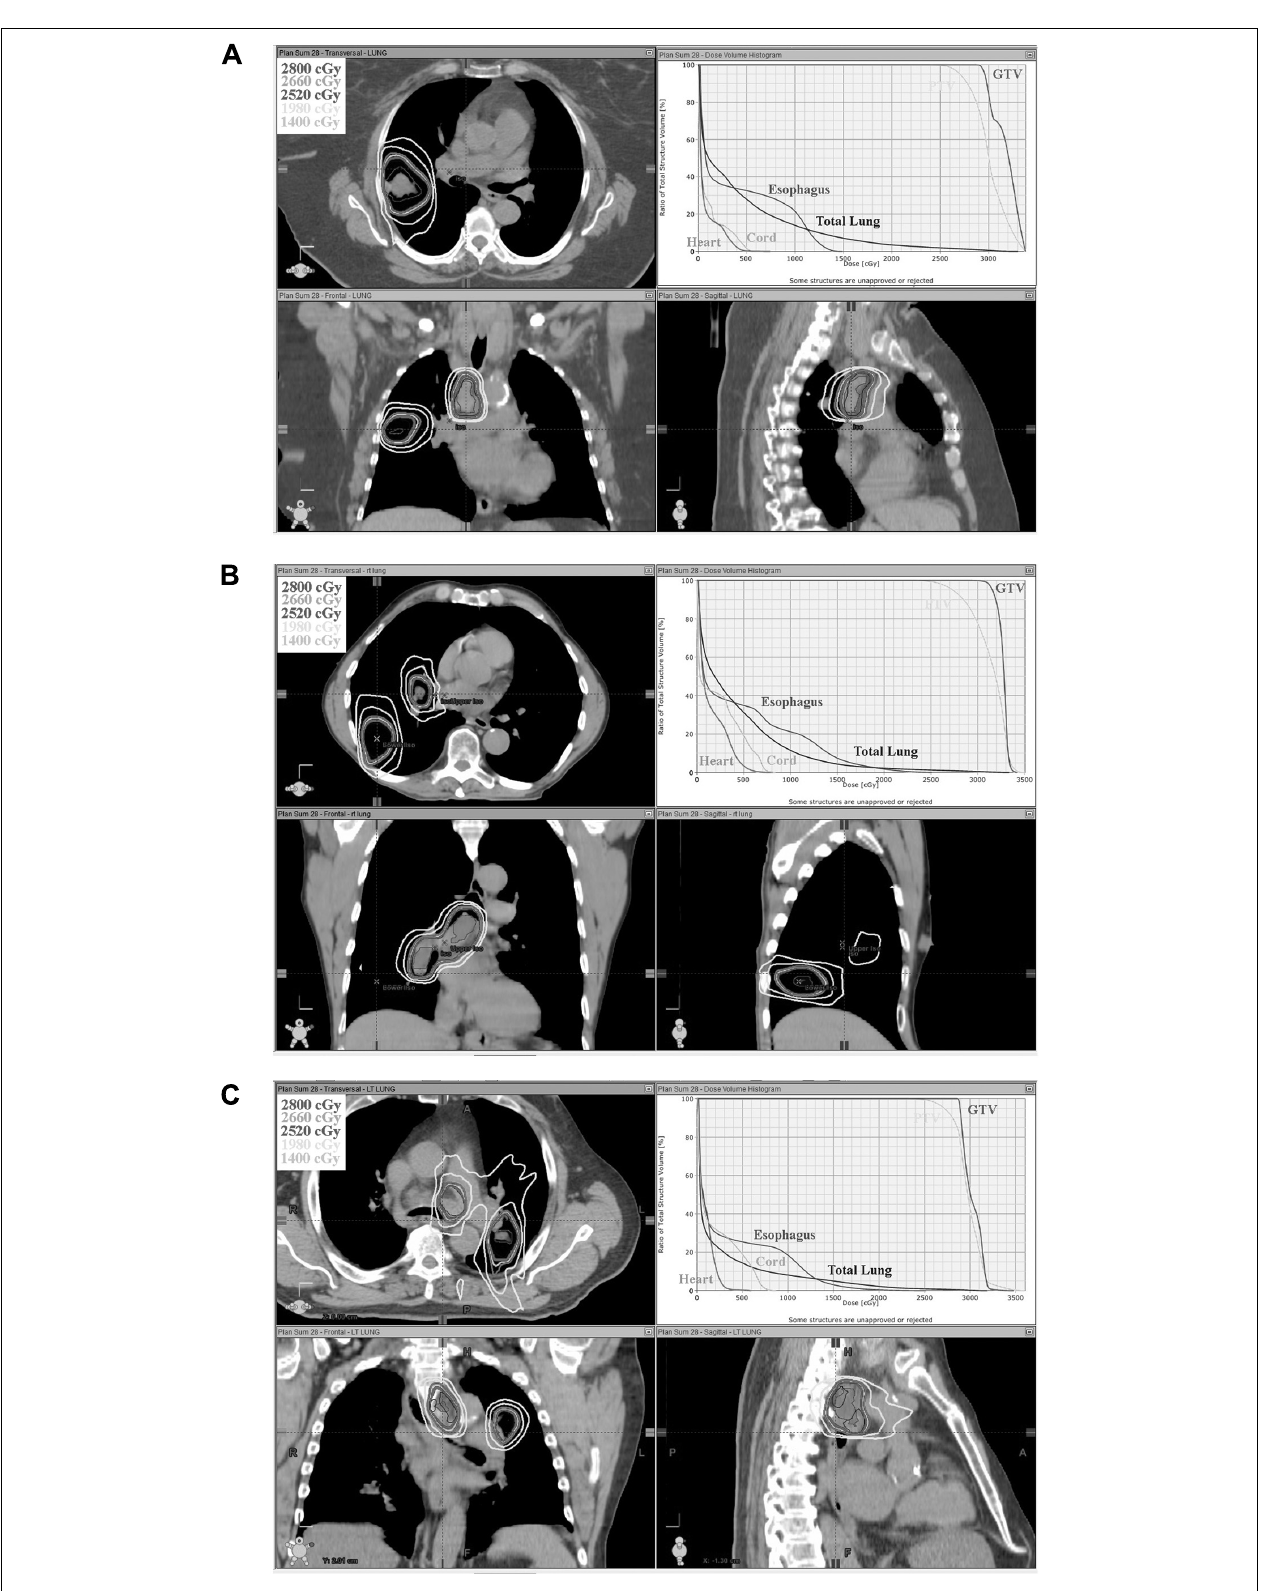
FIGURE 1 | Orthogonal isodose distribution and DVH of SBRT boost plan to 28 Gy in two fractions. Three separate cases are depicted in (A–C) .